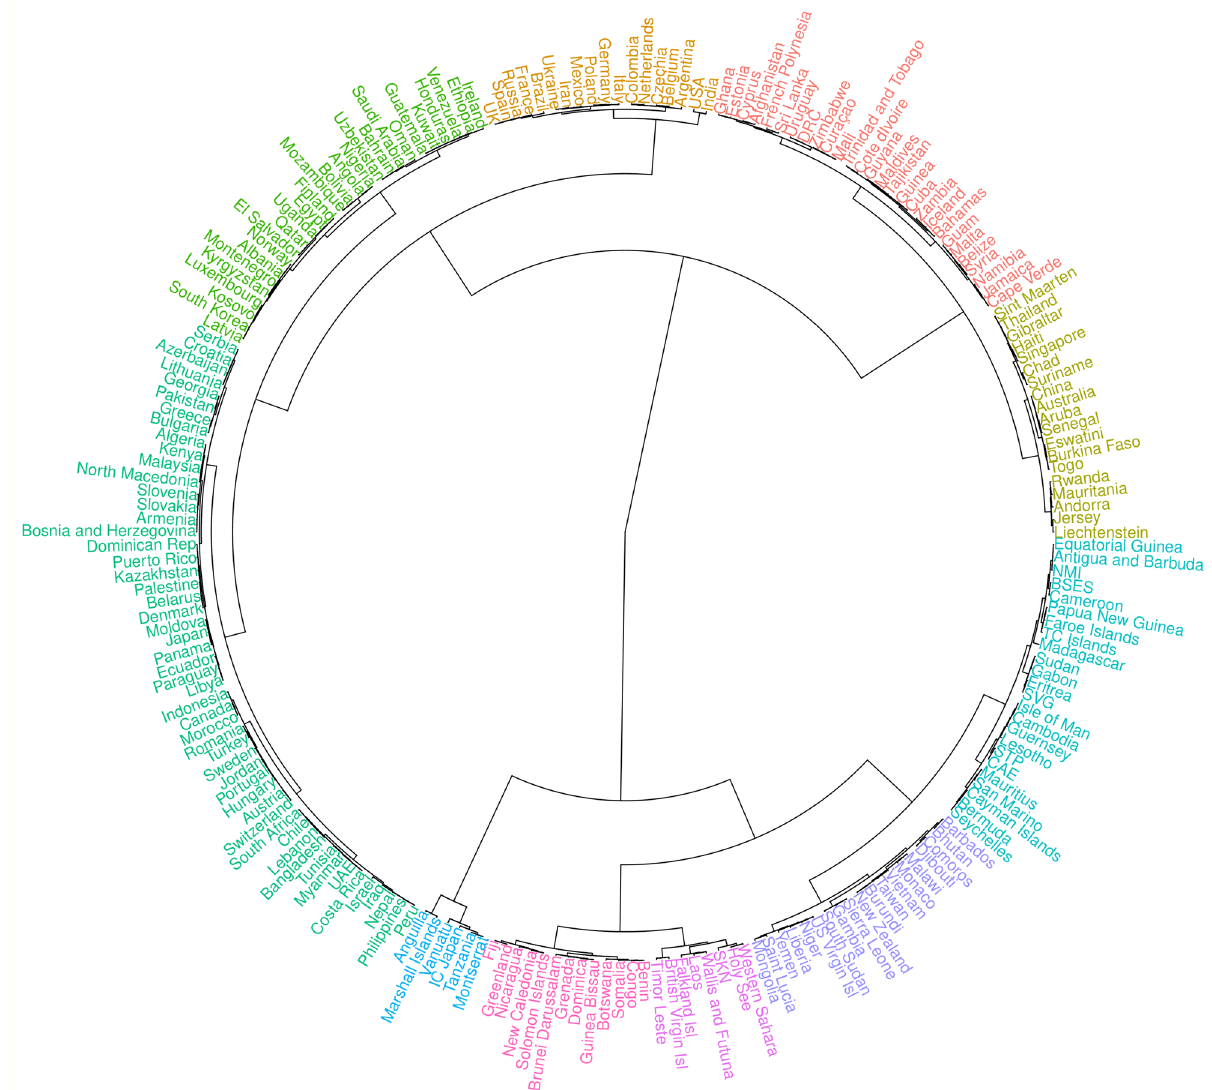
Figure 3. Dendrogram representing the hierarchical clustering of countries based on their estimated autoregressive parameters ˆ γ it from 26-Sep-2020 to 25-Nov-2020. The clustering used Ward’s method and pairwise dynamic time warp distances between the countries’ time series. Each of 10 clusters is represented with a different colour. Country abbreviations: BSES = Bonaire, Saint Eustatius and Saba; IC Japan = Cases on an international conveyance - Japan; CAE = Central African Republic; DRC = Democratic Republic of the Congo; NMI = Northern Mariana Islands; SKN = Saint Kitts and Nevis; SVG = Saint Vincent and the Grenadines; STP = São Tomé and Príncipe; TC Islands = Turks and Caicos Islands; UAE = United Arab